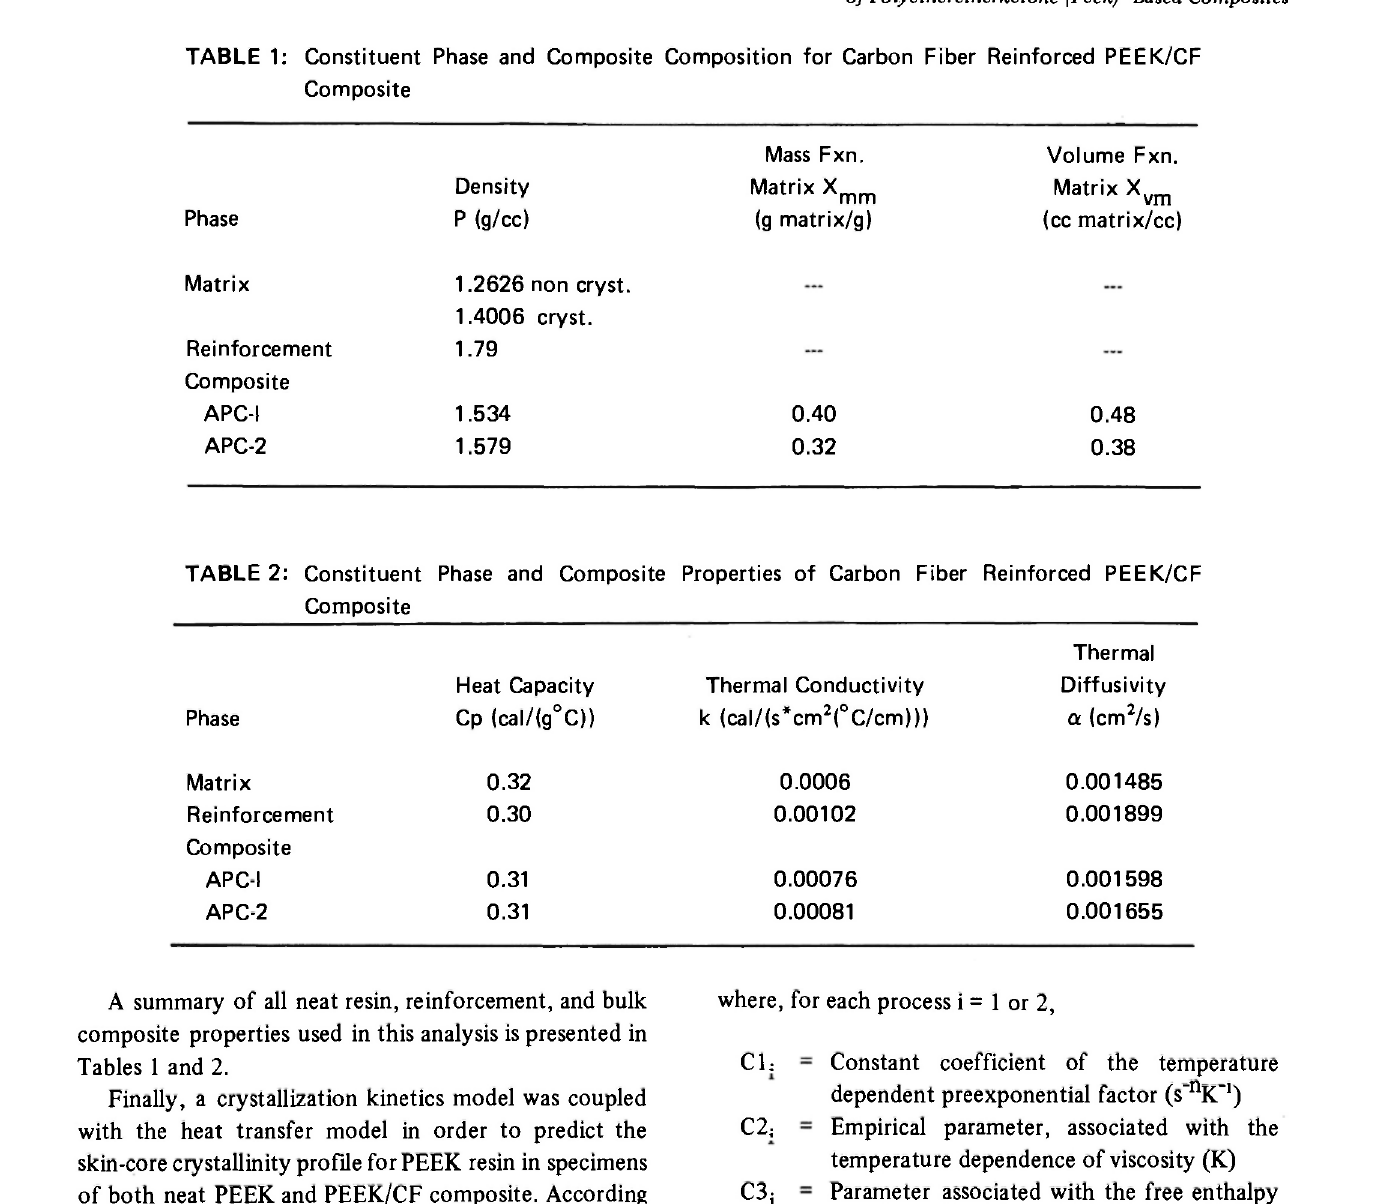
TABLE 1: Constituent Phase and Composite Composition for Carbon Fiber Reinforced PEEK/CF